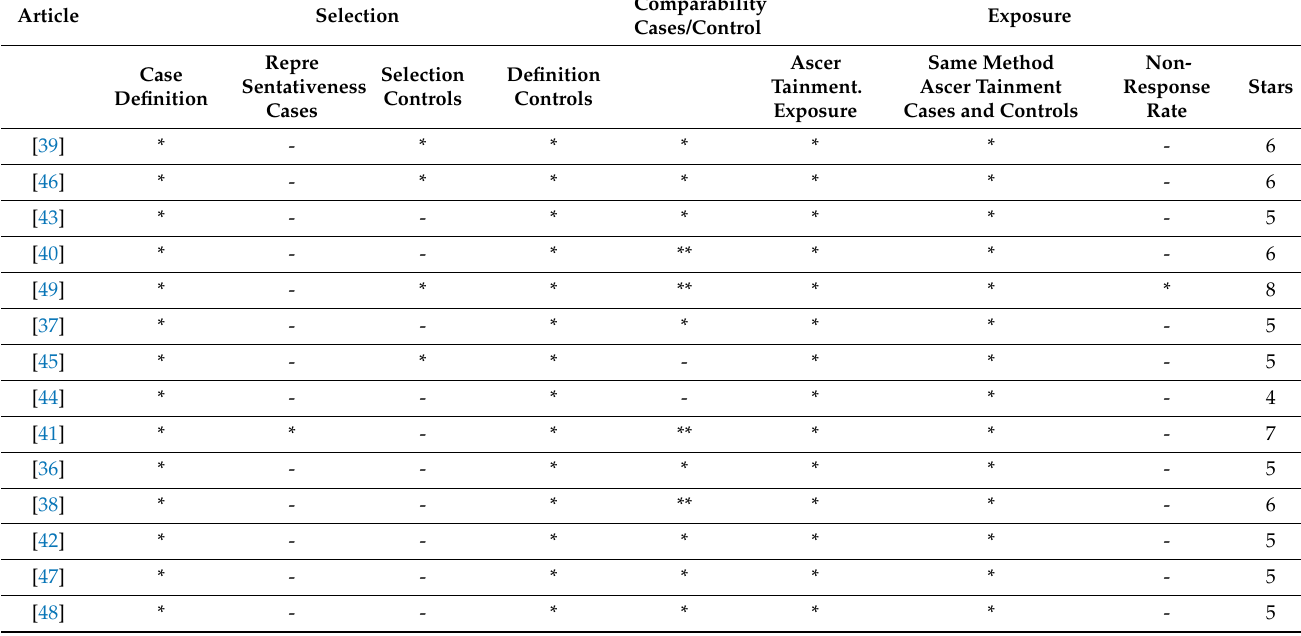
Table A2. Results of the Newcastle–Ottawa Quality Assessment Scale.